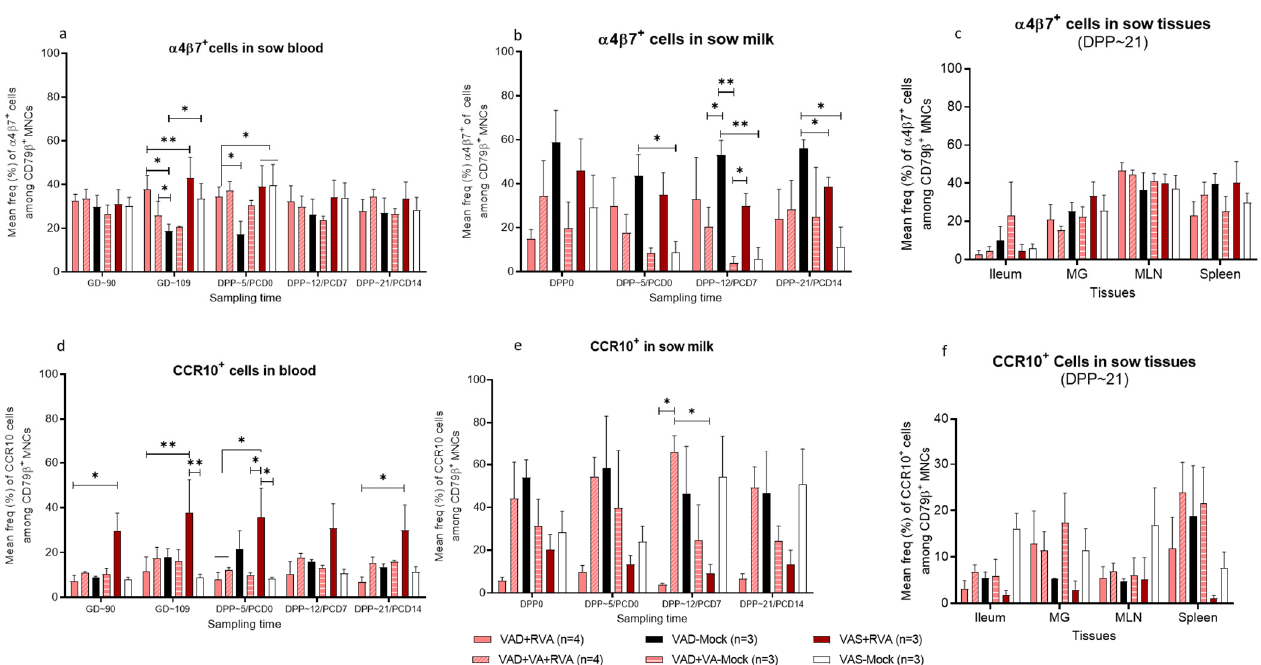
Figure 9. Mean frequencies (%) of α 4 β 7 + ( Upper ) and CCR10 + ( Lower ) cell subpopulations among B lymphocytes (CD79 β + ) in blood ( a , d ), milk ( b , e ) and tissues ( c , f ) of RVA (OSU) infected sows fed VAS and VAD ( ± VA) diets during gestation and postpartum. (* p < 0.05; ** p < 0.01) (MLN, mesenteric lymph nodes; MG, mammary gland).